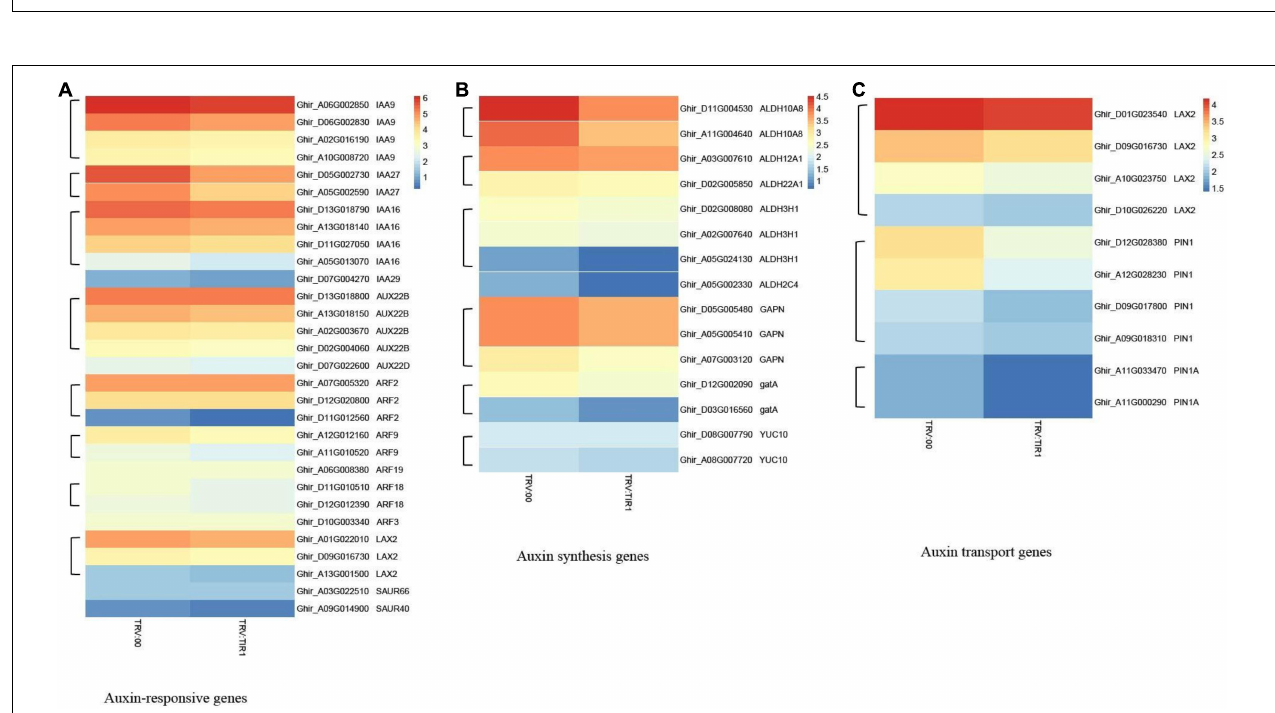
FIGURE 10 | GhTIR1 knockdown downregulated the expressions of the auxin-related genes via transcriptome analysis. Transcript contents of auxin-responsive genes (A) , auxin synthesis genes (B) , and auxin transport genes (C) . The FPKM value was normalized to log2 (FPKM value) for the heatmap.